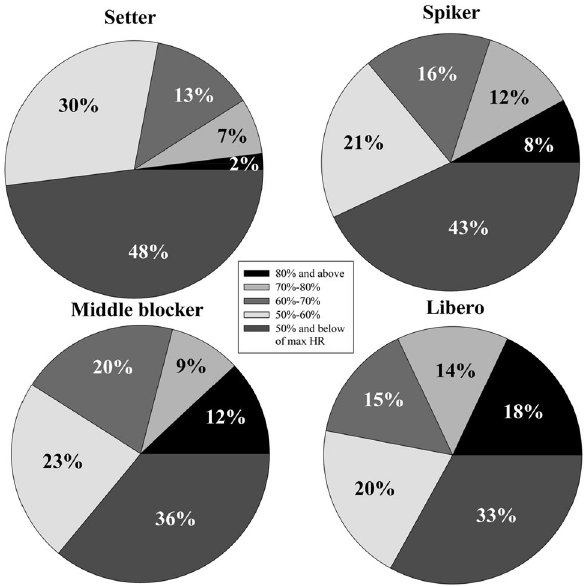
Figure 3. The time spent by the volleyball players in the determined ranges of their HR max before, during and after the volleyball match